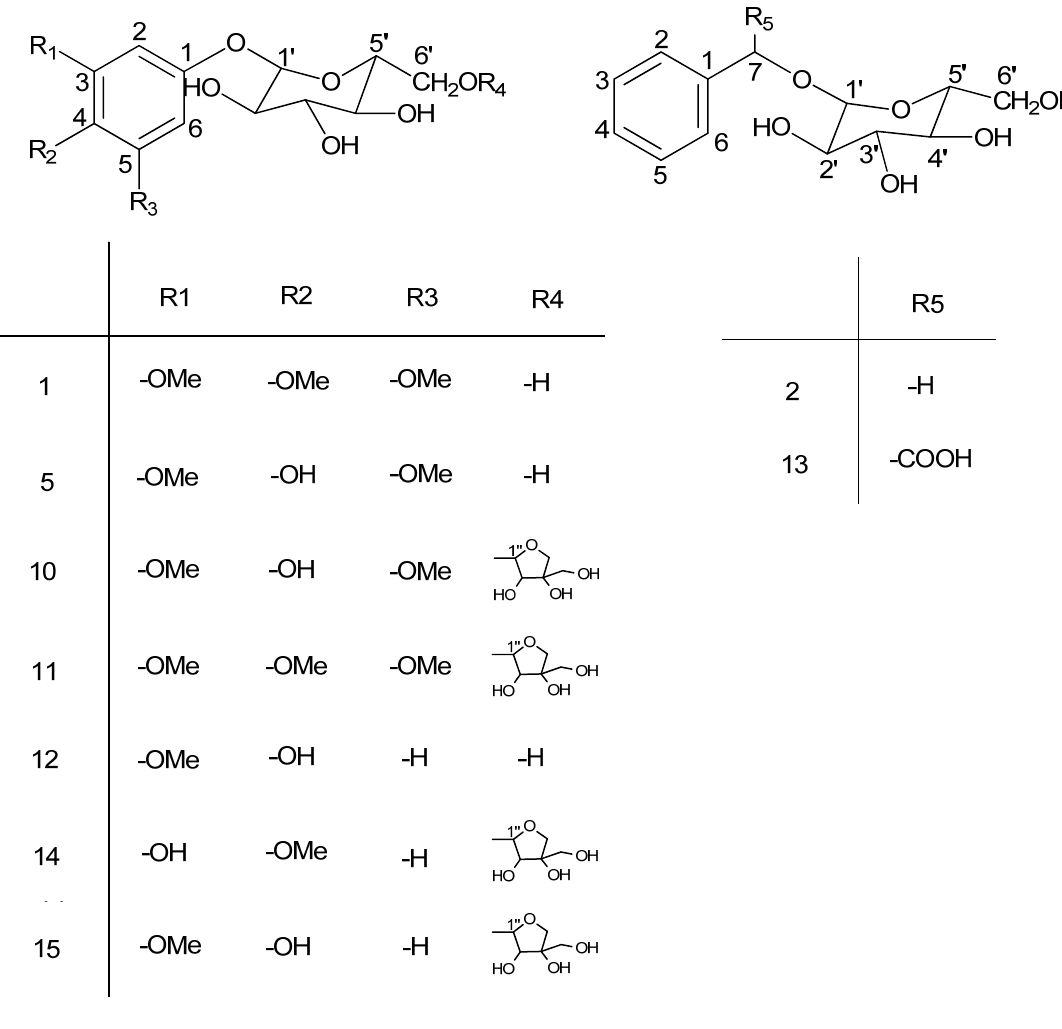
Figure 2. Structures of compounds 3 , 4 and 6 – 9